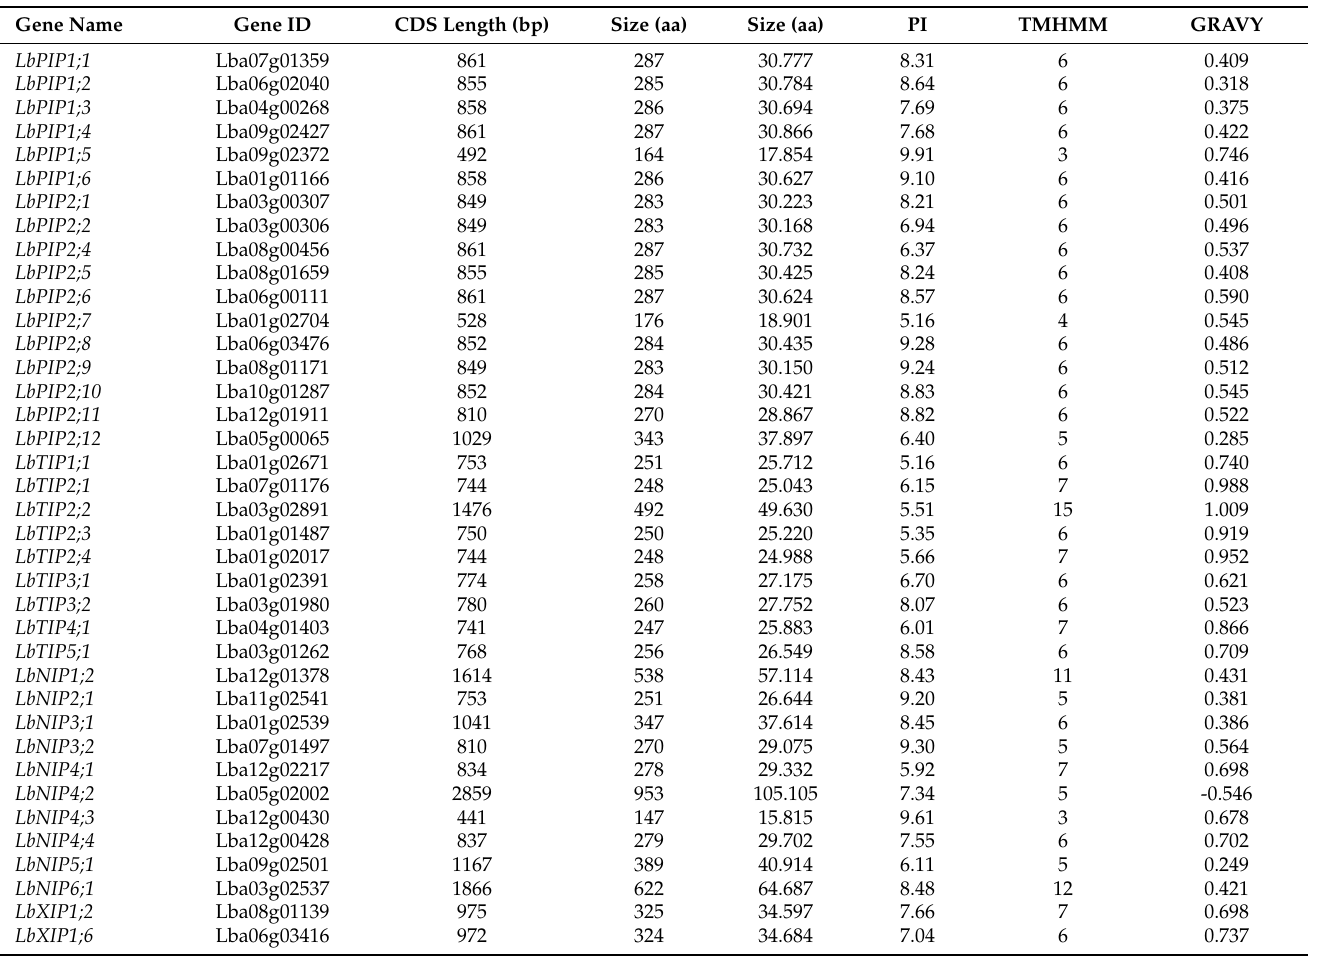
Table 1. Detailed information on 38 aquaporin (AQP) genes of Lycium ( L. ) barbarum and their encoded